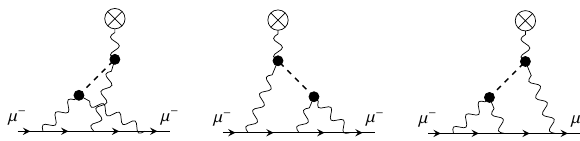
Figure 2. The three one-pion exchange HLbL diagrams. The dashed line denotes the pion propagator and the black dots the TFF at each anomalous π 0 γ ∗ γ ∗